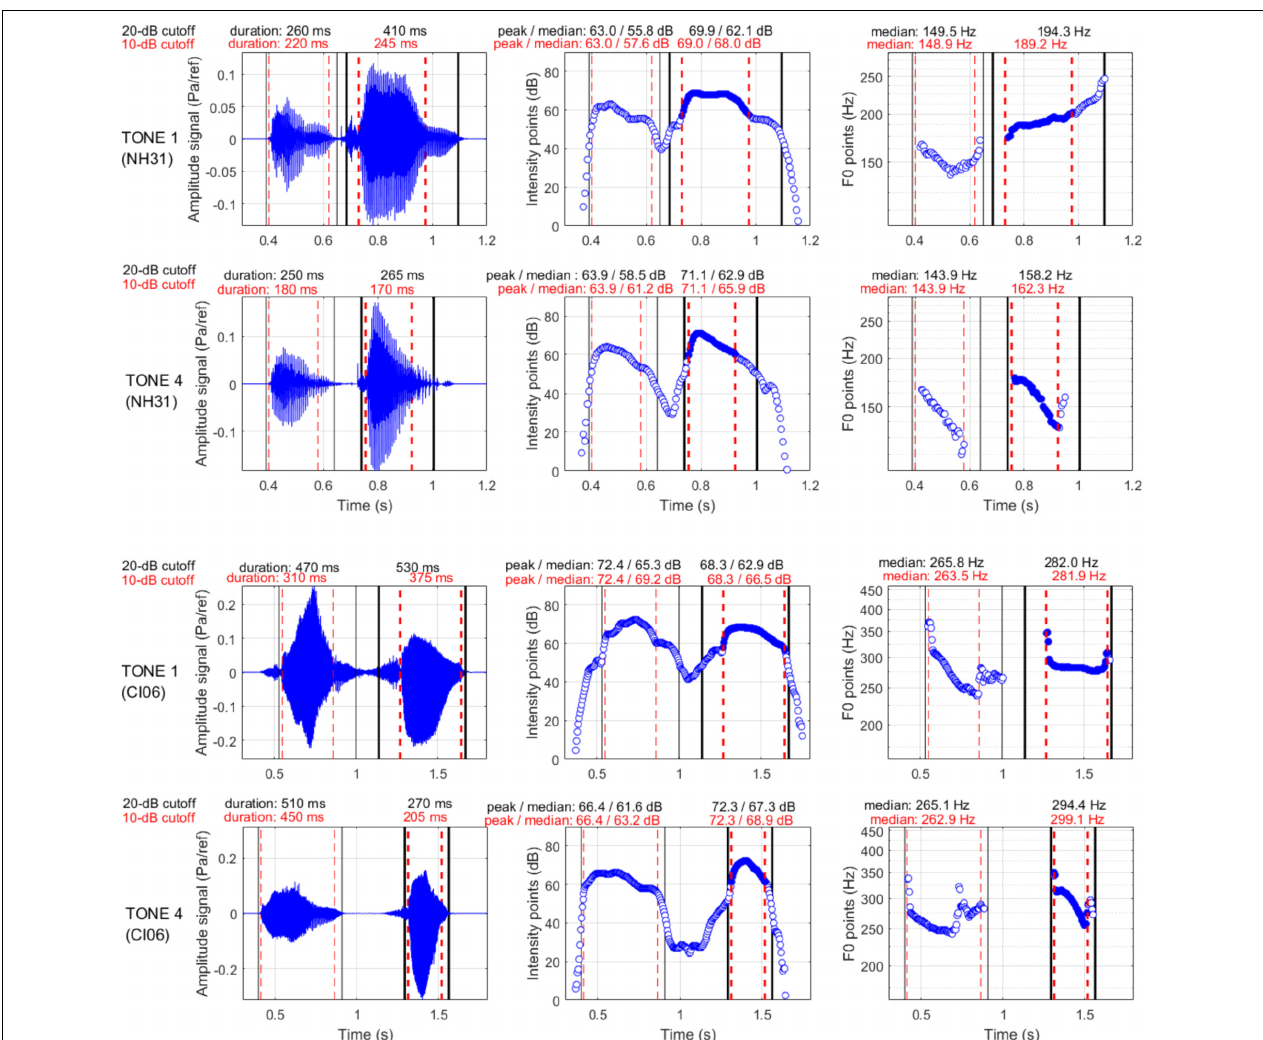
FIGURE 1 | The “yan-jing” production, with the second syllable produced as Tone 1 (top) or Tone 4 (bottom) by a 12.7-year-old participant with NH (top two rows) and by a 10.9 year-old participant with a CI (bottom two rows).